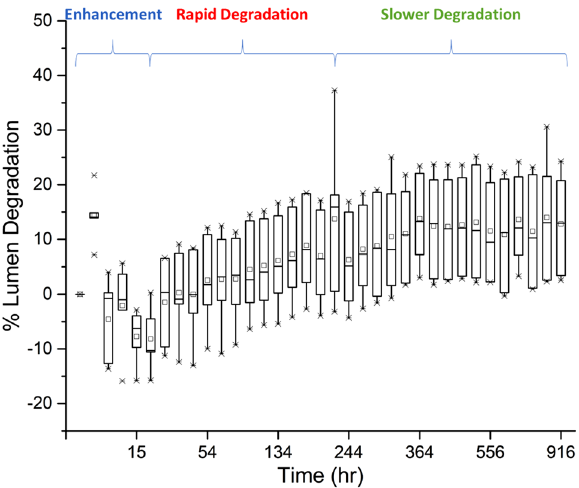
Figure 2. Overall LED luminescence variation with time (The whiskers indicate the outlier points in each dataset. The line in the middle of the box represents the value of median range for each dataset).